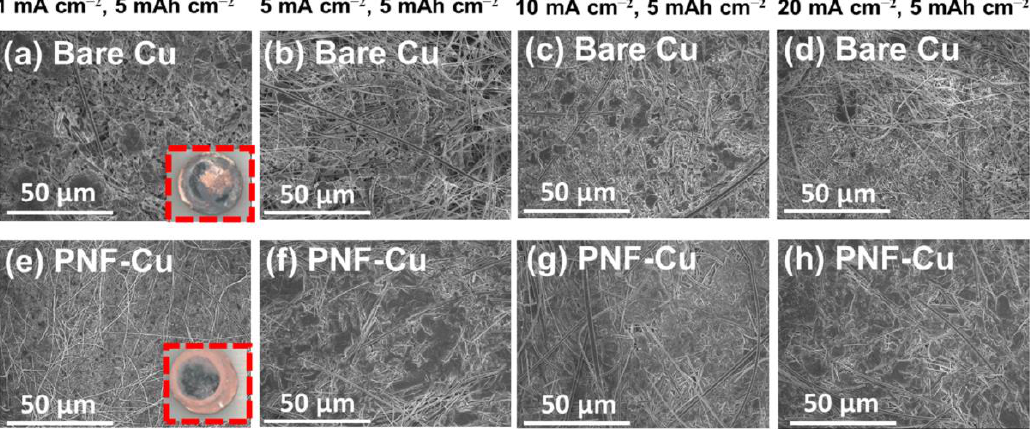
Figure 3. Top-view SEM images of Zn deposition morphology on ( a – d ) bare Cu electrode and ( e – h ) PNF-Cu under various current densities and fixed areal capacity of 5 mAh cm −2